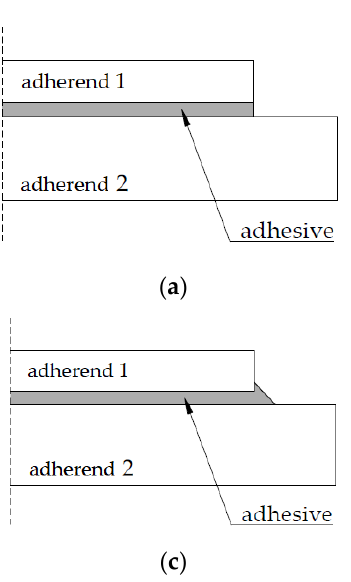
Figure 1. Geometric parameters of adhesive layers: ( a ) square edge; ( b ) rounded spew fillet; ( c ) small spew fillet; ( d ) full spew fillet.